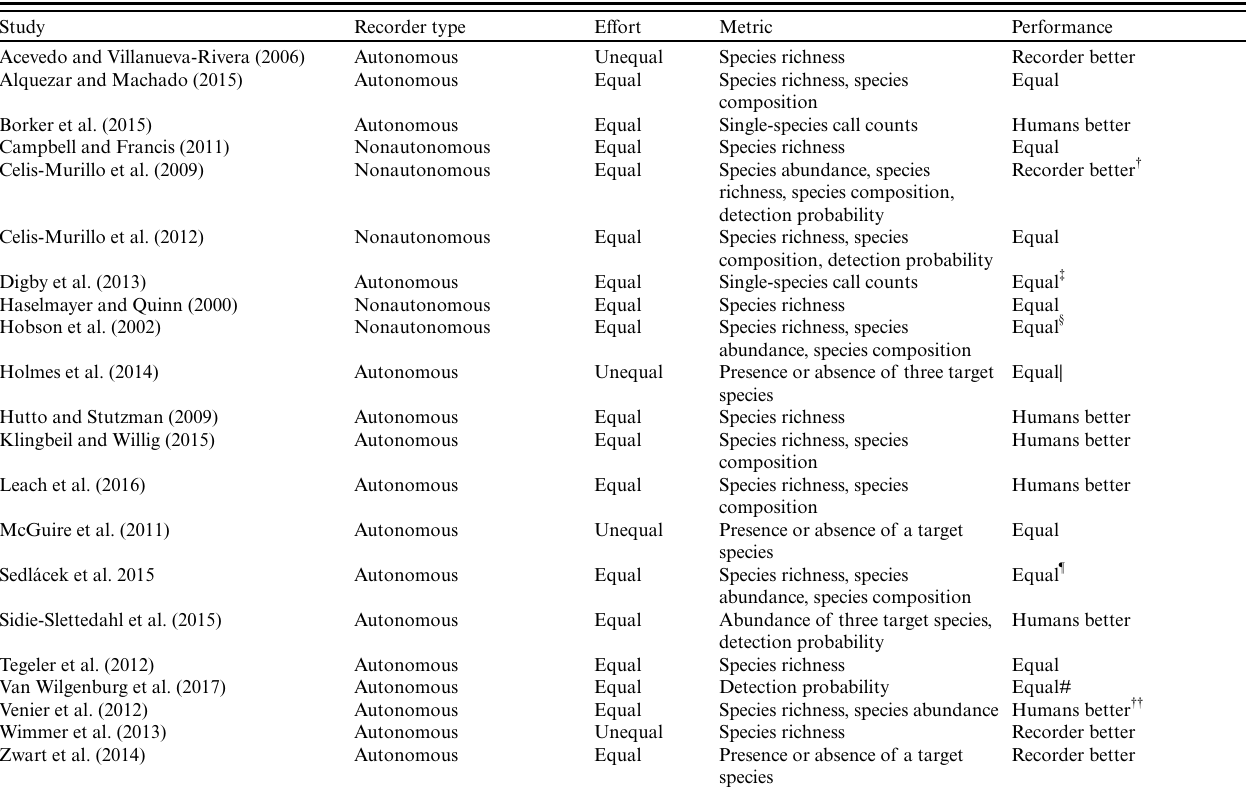
Table 1. Summary of studies that evaluated the performance of autonomous and nonautonomous acoustic recorders compared to traditional avian point counts by a human observer in the field. Studies were considered to have equal effort between the two methods if each method sampled for the same cumulative amount of